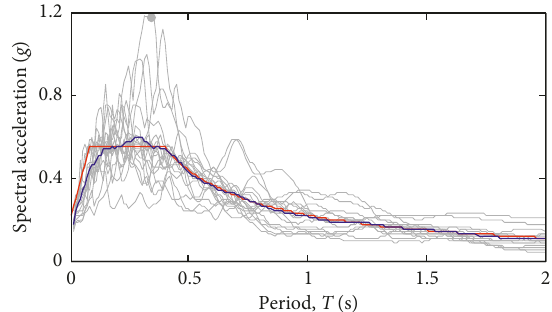
Figure 6: Average response spectra of input accelerations.